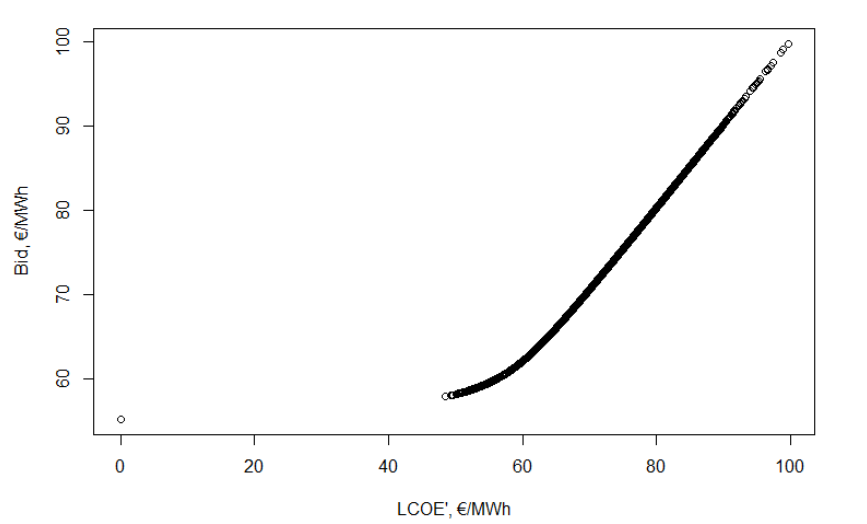
Figure 6. The optimal bidfunction assuming F 1 bid distribution, source: own